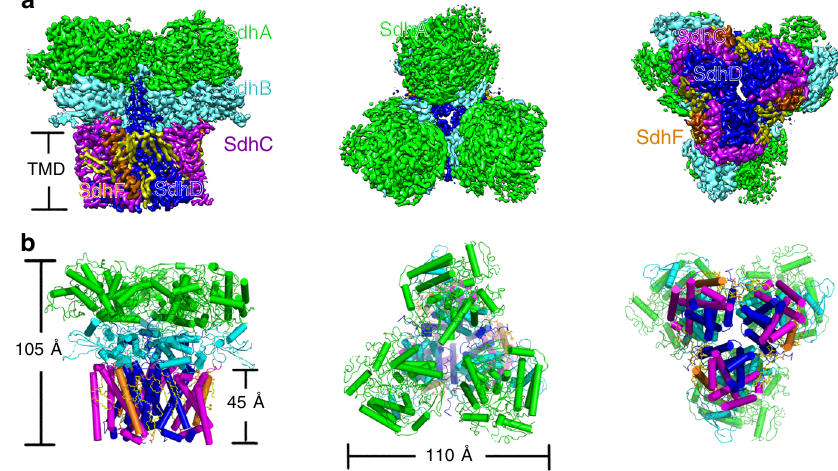
Fig. 1 Overall architecture of the Sdh2 trimer from M. smegmatis . a Cryo-EM map of Sdh2 trimer at 2.8 Å resolution. Left: front view; middle: top view (from cytoplasm); right: bottom view (from periplasm). SdhA, SdhB, SdhC, SdhD, and SdhF subunits are colored in green, cyan, purple, blue, and orange individually. Lipids are colored in yellow. b Cartoon representation of Sdh2 trimer, using the same color scheme as